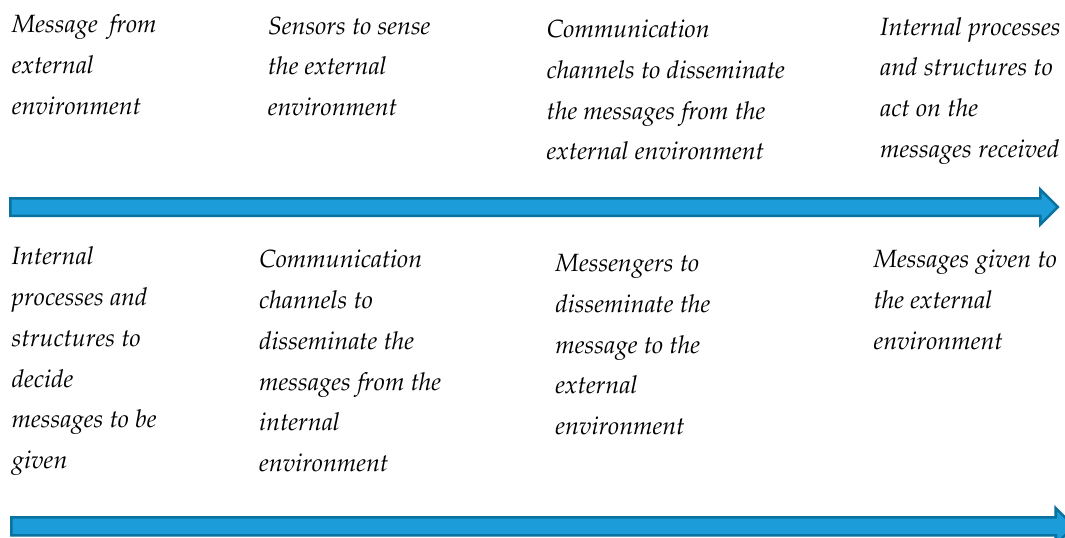
Figure 1. Schools sensing and responding to their environment. Adapted from Morrison [19] (p. 121).